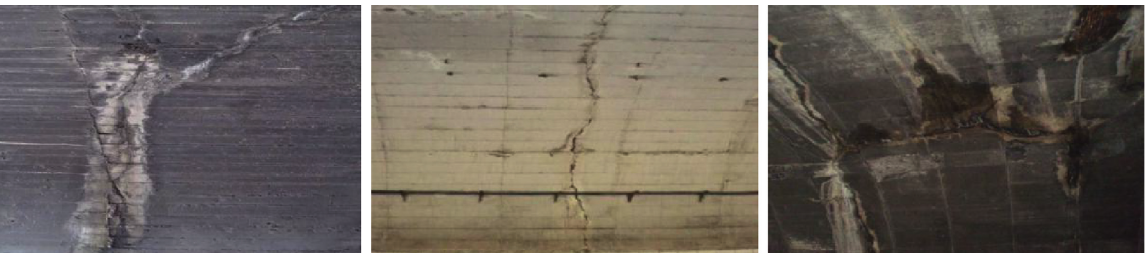
Figure 2: Diagram of the tunnel crack